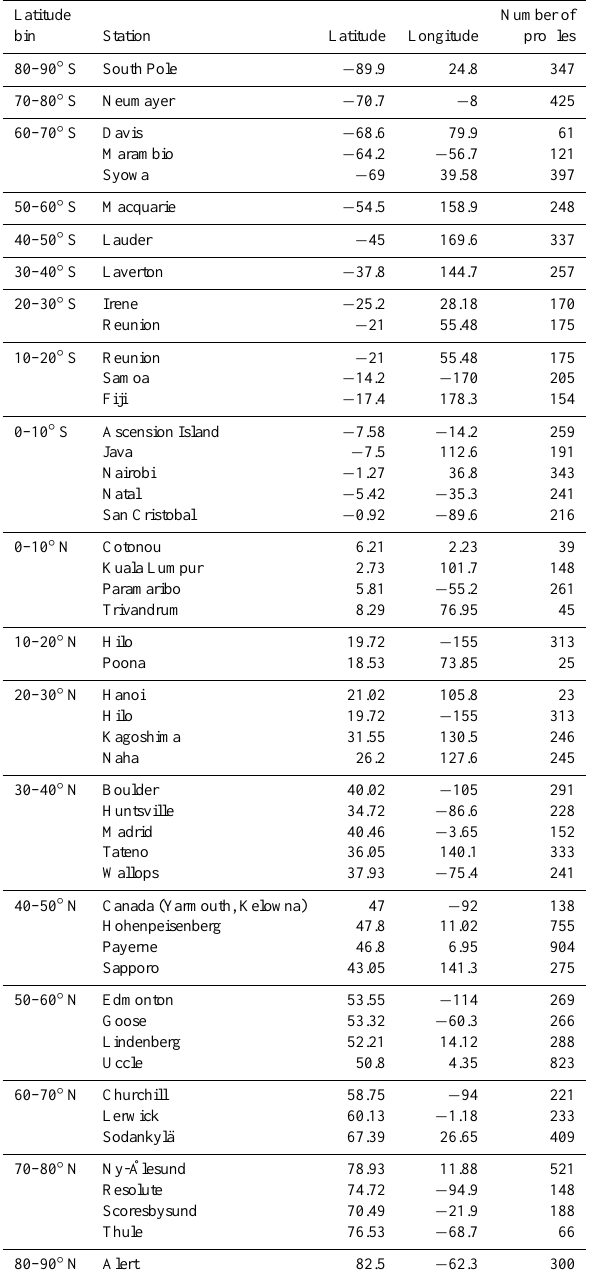
Table 1. List of ozonesonde stations used to estimate inter-annual ozone variability for smoothing error calculations over the time pe- riod from 1 January 2000 to 31 December 2005.